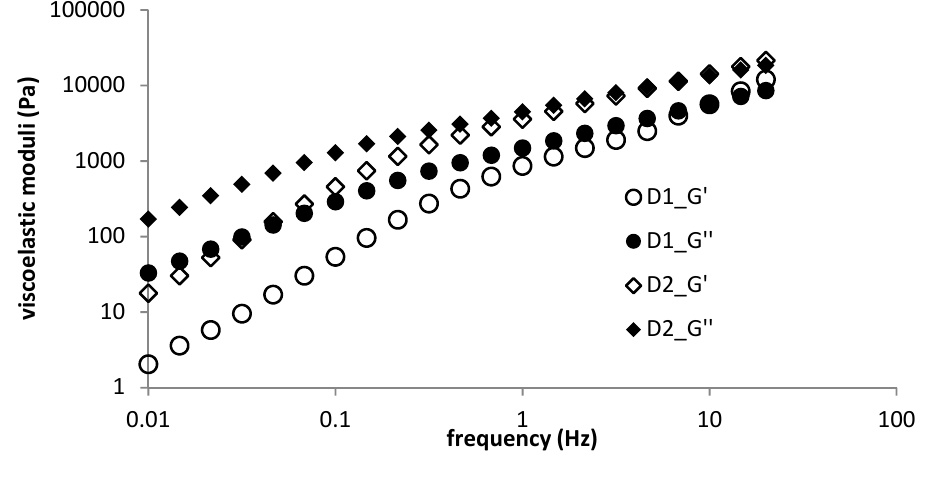
Figure 1. Frequency sweep for diethylaminoethyldextran hydrochoride (DEAE) hydrogels—concentration dependence.